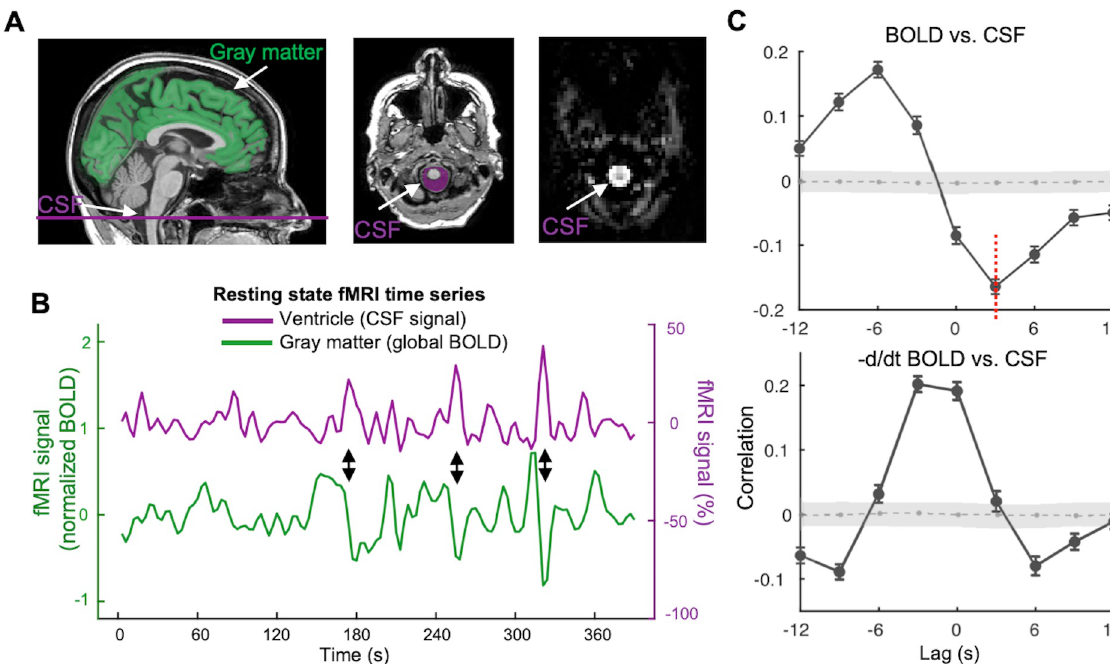
Fig 1. The global BOLD signal is coupled with CSF changes. ( A ) The global BOLD signal was averaged across the gray matter regions (the green mask on an exemplary T1-weighted image in the left panel), whereas the CSF signal was extracted from the CSF regions at the bottom slice of the fMRI acquisition (the middle and right panel). The CSF appears much brighter than the surrounding areas in the T2 � -weighted fMRI image (the right panel). ( B ) The global BOLD signal and the CSF signal from a representative participant showed corresponding changes (indicated by black arrows). We also included a different version of the global BOLD signal in percentage changes to show the amplitude of signal fluctuation ( S12A Fig ). ( C ) The cross-correlation function between the global BOLD signal and the CSF signal averaged across 158 sessions (upper) and the one between the negative derivative of global BOLD signal and the CSF signal (lower). The gray shaded region denotes 95% confidence intervals calculated with shuffled signals (see Materials and methods for details; see S12B Fig for all the 158 cases and their standard deviation (SD) of the BOLD–CSF cross-correlation function). Gray dashed lines in the shaded region shows mean correlation of the null distribution from permutation test at each time lag. Error bar in this figure represents the SEM. These cross-correlation functions show a very similar shape to those reported in the previous study [48]. The cross-correlation ( − 0.17, p < 0.0001, permutation test) at the +3-second lag (red dashed line), which also showed the strongest coupling in the previous study [48], was used for quantifying the BOLD–CSF coupling for subsequent analyses. The data underlying this figure can be found in S1 Data. BOLD, blood oxygen level– dependent; CSF, cerebrospinal fluid; fMRI, functional magnetic resonance imaging; SEM, standard error of the